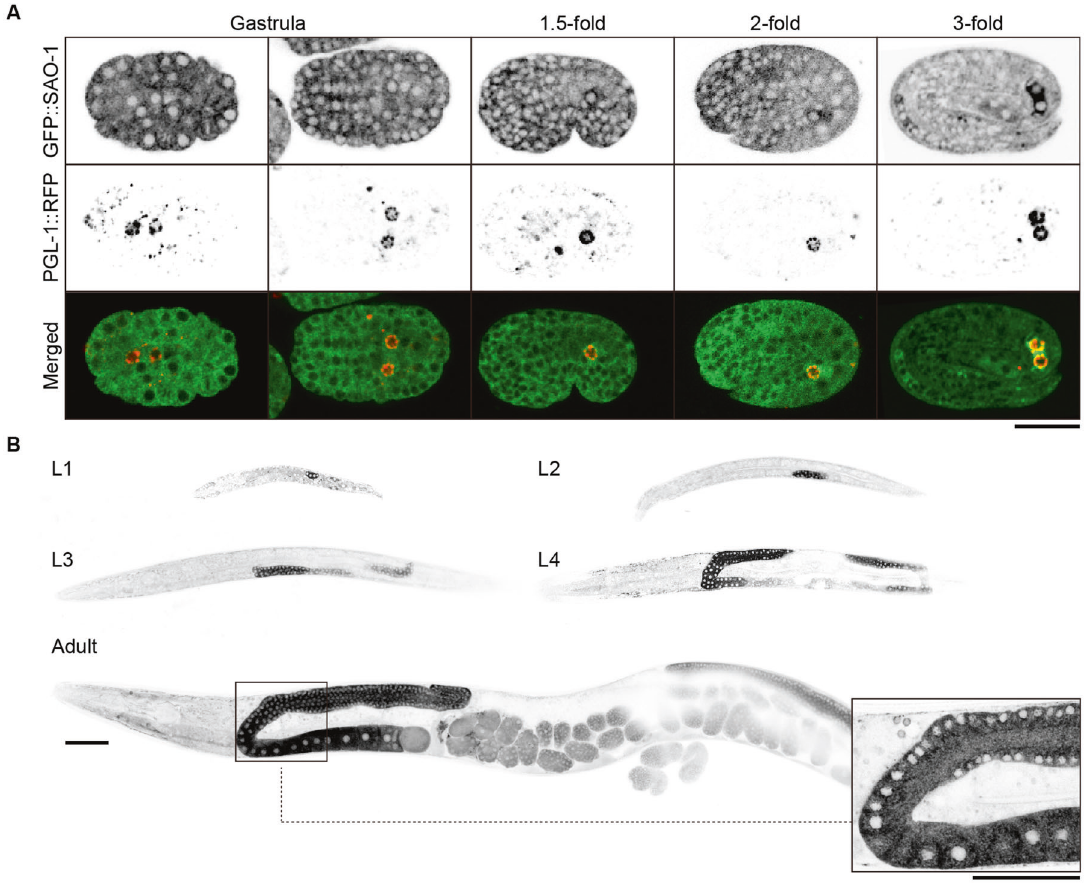
Fig. 1 The expression of SAO-1 in C. elegans primordial germ cells and germline. A Representative confocal images of the expression of GFP::SAO-1 in the embryos at the gastrula stage, 1.5-fold stage, 2-fold stage and 3-fold stage. Scale bar, 20 μ m. B Representative confocal images of the expression of GFP::SAO-1 in worms at L1, L2, L3, L4 and adult stage. Scale bar, 50 μ